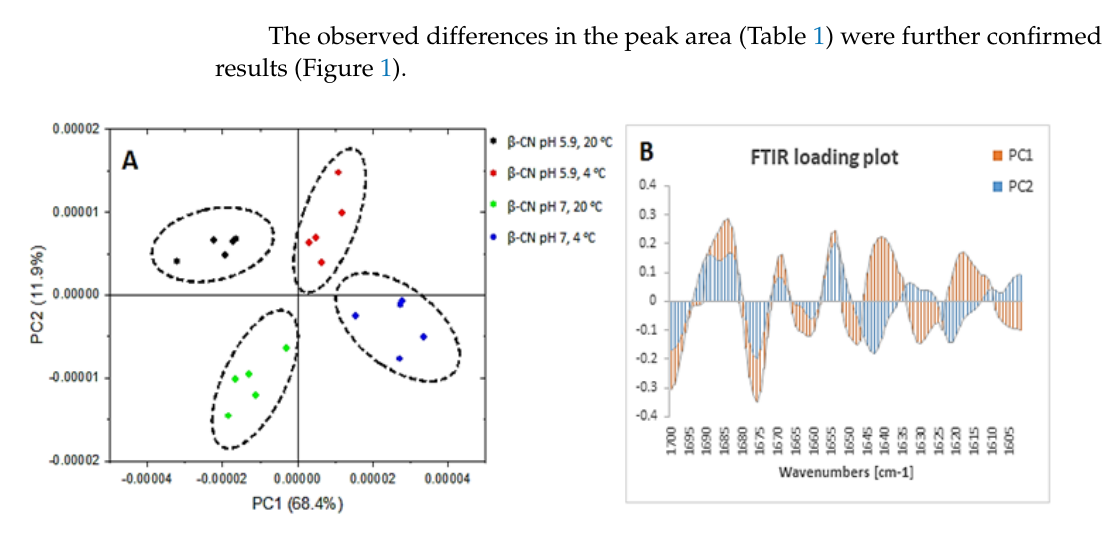
Figure 1. Principal components score plot ( A ) and loading plot ( B ) of β -casein of the FTIR spectra in region 1700–1600 cm − 1 where β -casein at pH 5.9 and temperature of 20 ◦ C (black), β -casein at pH 5.9 and temperature of 4 ◦ C (red), β -casein at pH 7.0 and temperature of 20 ◦ C (green) and β -casein at pH 7.0 and temperature of 4 ◦ C (blue) are in ( A ) and PC1 (orange) and PC2 (blue) are in ( B ) .